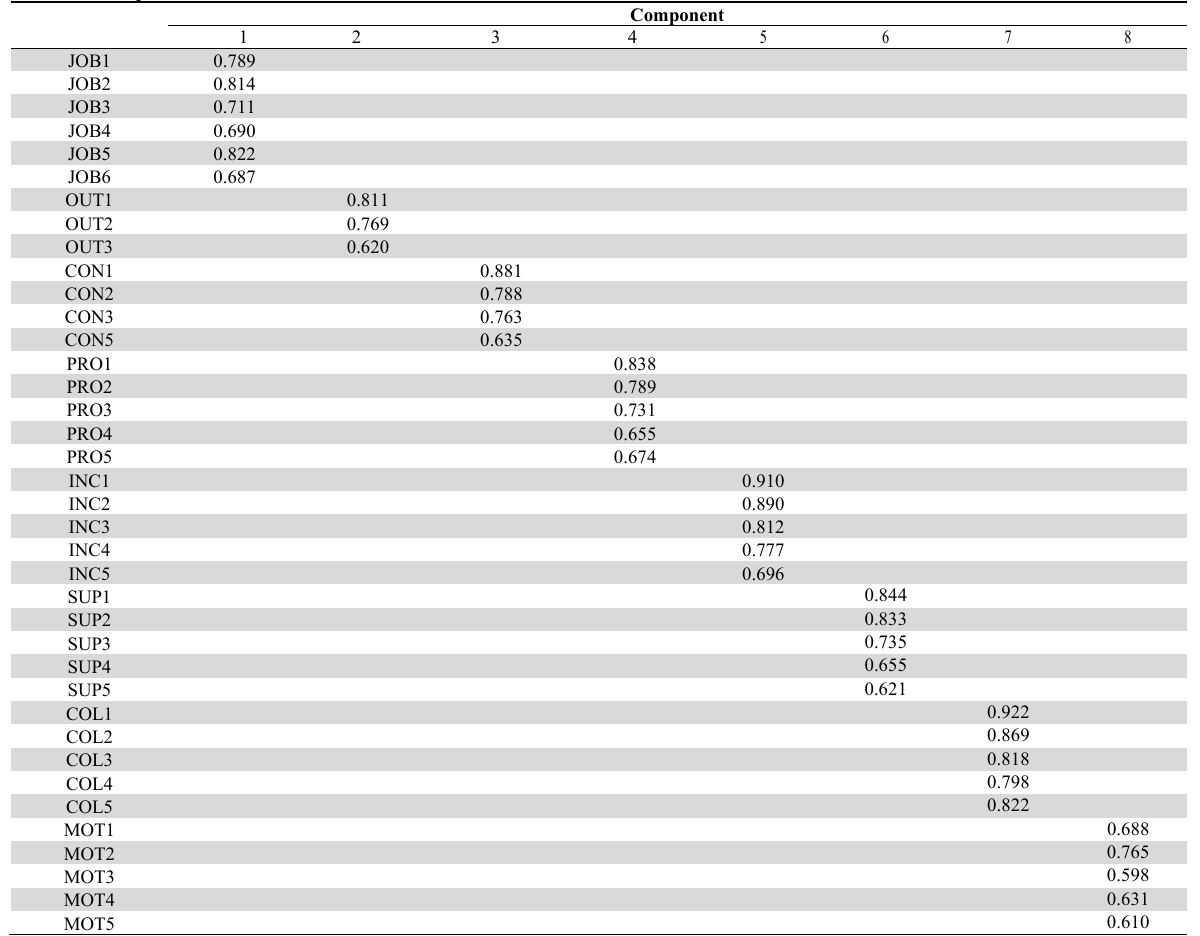
Rotated Component Matrix